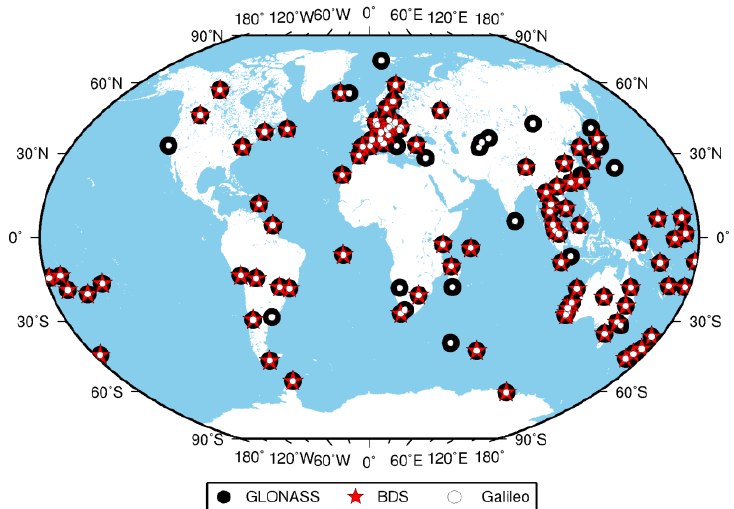
Figure 1. Number of MGEX ground tracking stations.